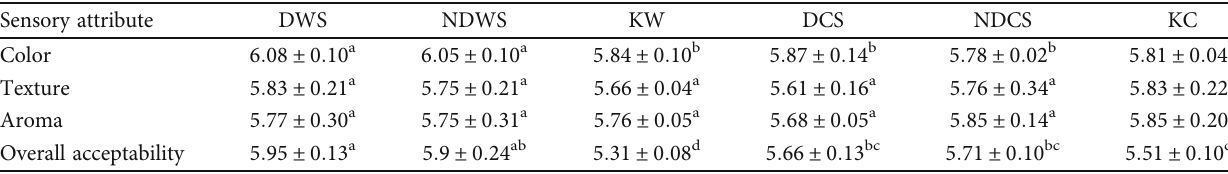
Table 4: Sensory analysis of dried chili